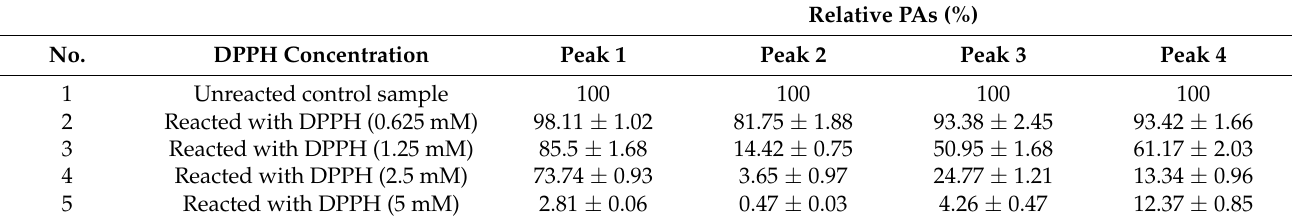
Table 1. Relative PAs of peak 1 (quercetagetin-7- O -glucoside), peak 2 (quercetagetin), peak 3 (quercetin) and peak 4 (patuletin) after reaction with different concentrations of DPPH. Relative PAs